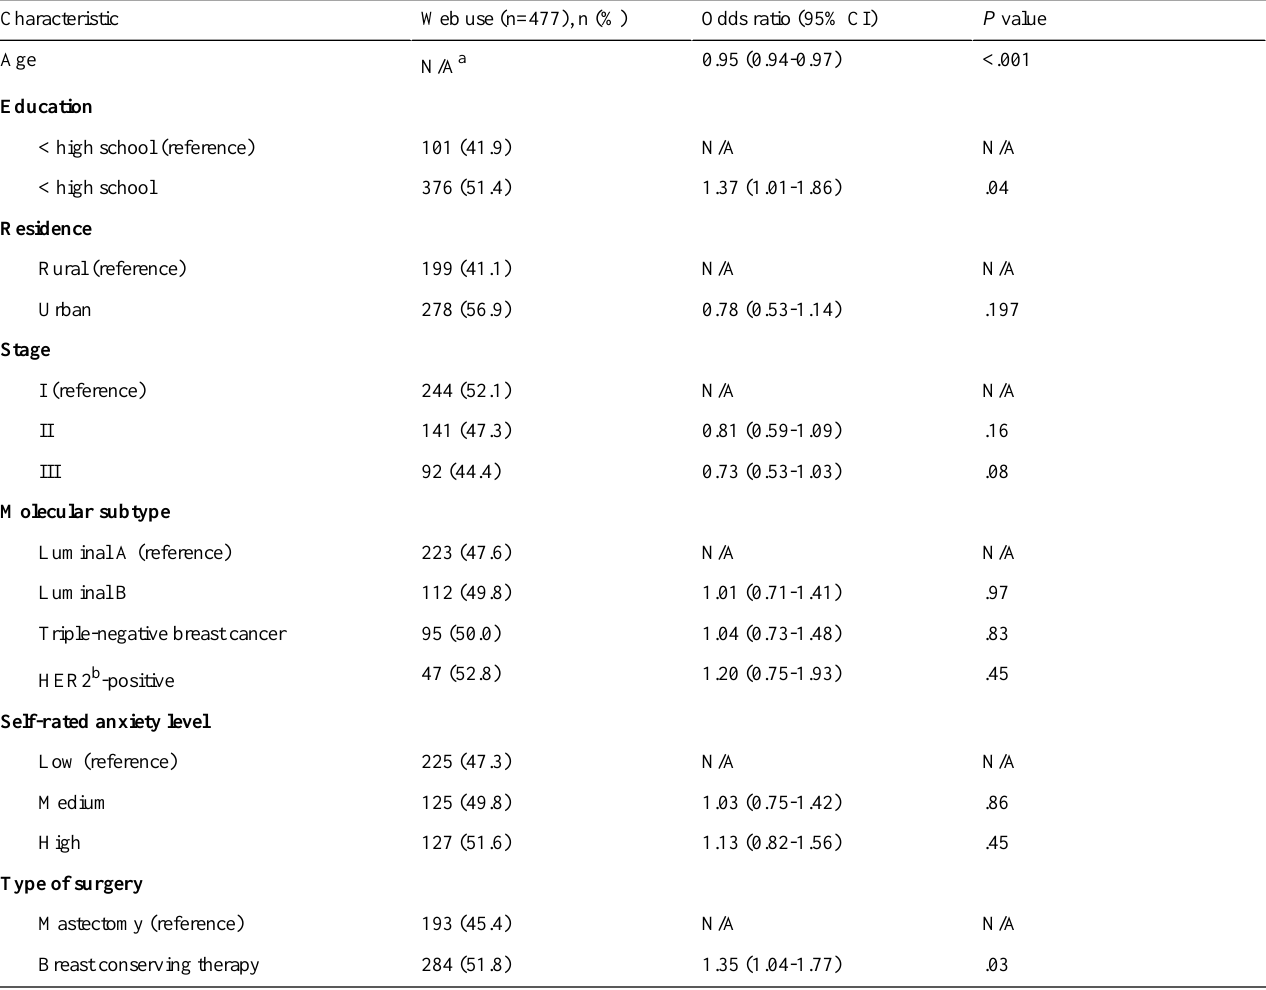
Table 2. Multivariate logistic analysis of the association between web-based information seeking and patient